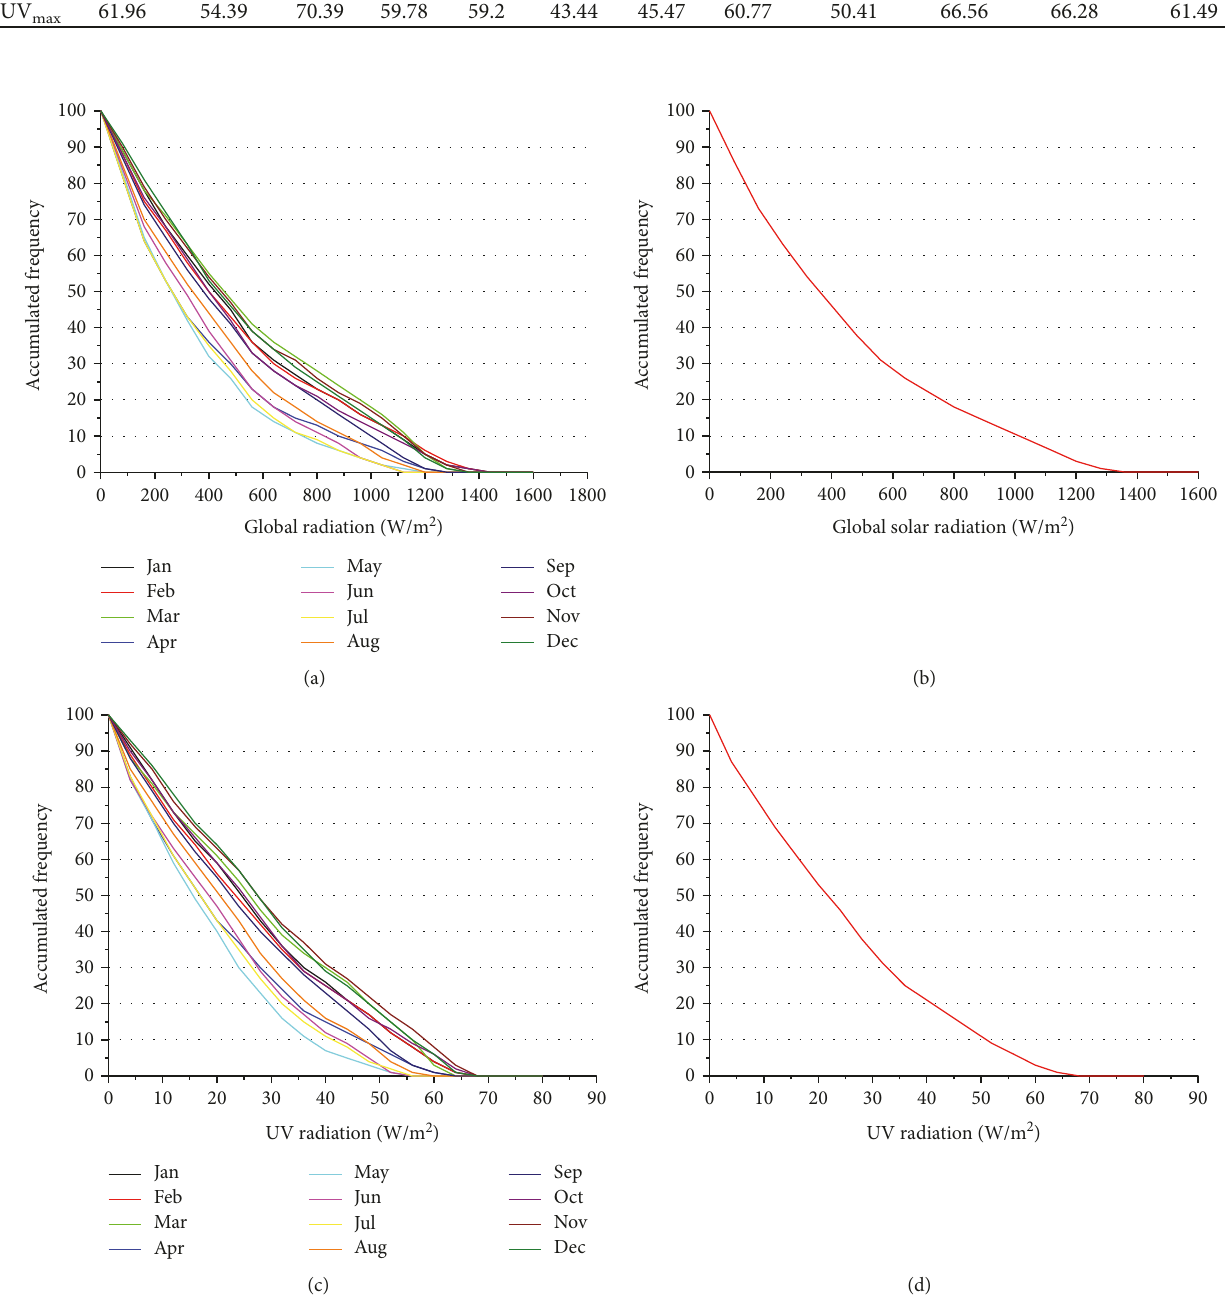
Figure 6: Monthly (a and b) and annually (c and d) accumulated distribution of global solar and UV